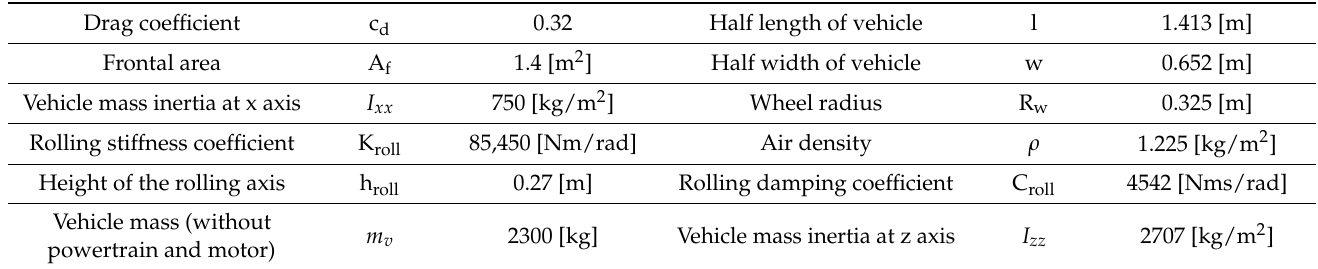
Table 1. Specifications of the selected autonomous electric